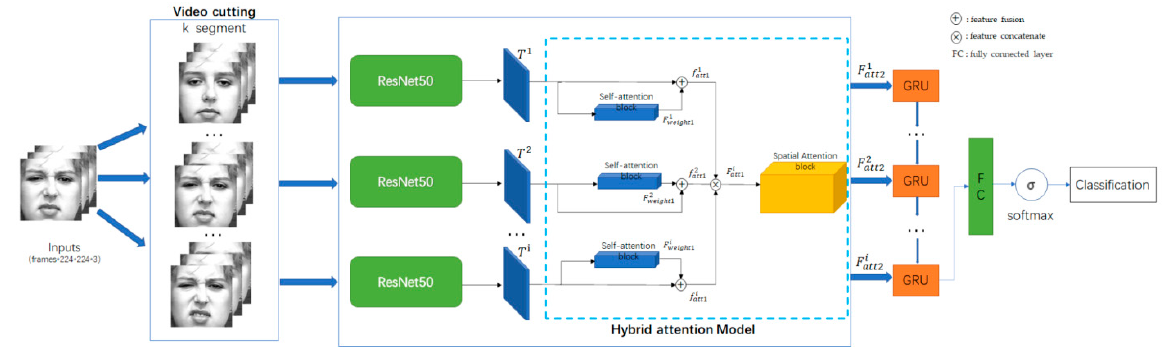
Figure 1. Structure of proposed hybrid attention network model. We note that k represents segments of frames; T i represents the spatial feature of the i th frame extracted by ResNet50; F i represents the self-attention feature vector; f i represents the outputs by feature fusion operation; F i represents the combined output by feature concatenate operation; F i represents the feature vector of the hybrid attention module; FC represents the fully connected layer; +represents the feature fusion operation; ×represents the feature concatenate operation.